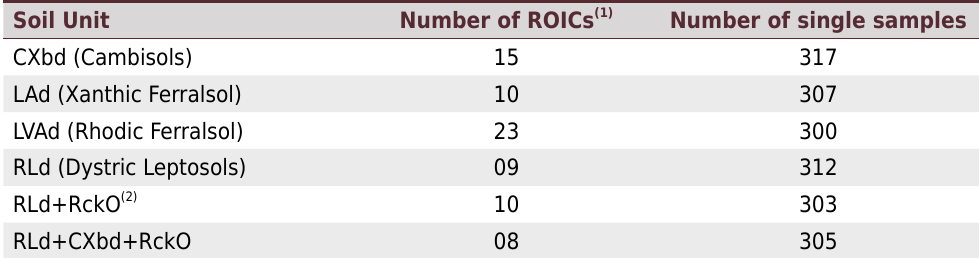
Table 1. Distribution of ROICs and samples by soil